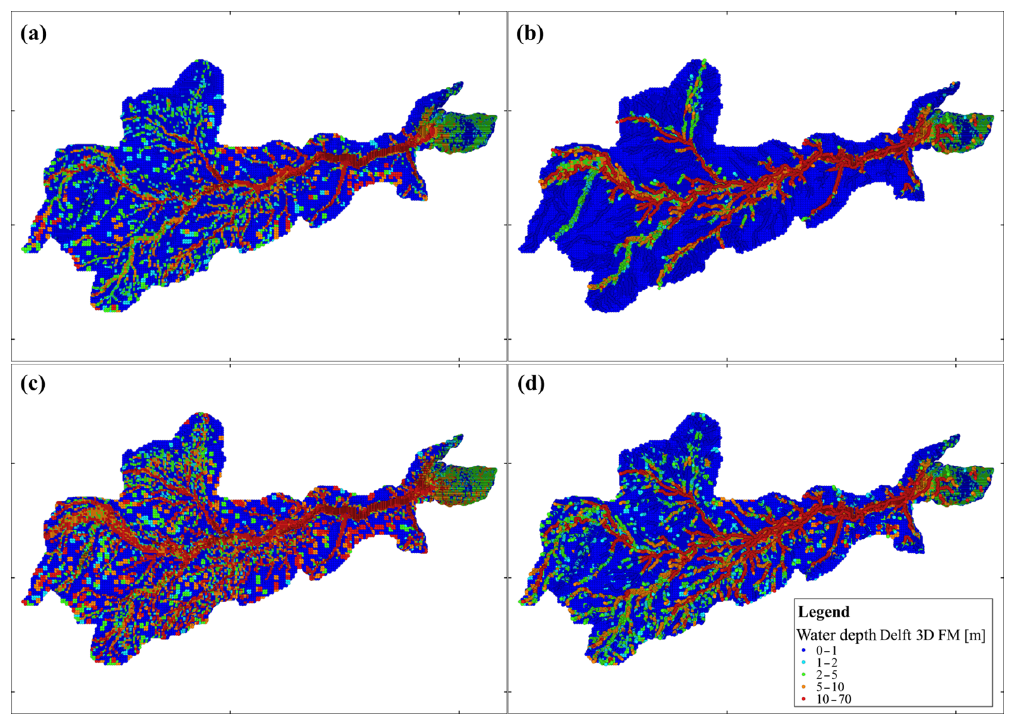
Figure 9. Plots of simulated water depth for 31 October 1990 for all runs with Delft 3D FM: (a) 2-D GRDC run; (b) 1-D/2-D GRDC run; (c) 2-D one-way (1way) run; and (d) 1-D/2-D one-way (1way) run.